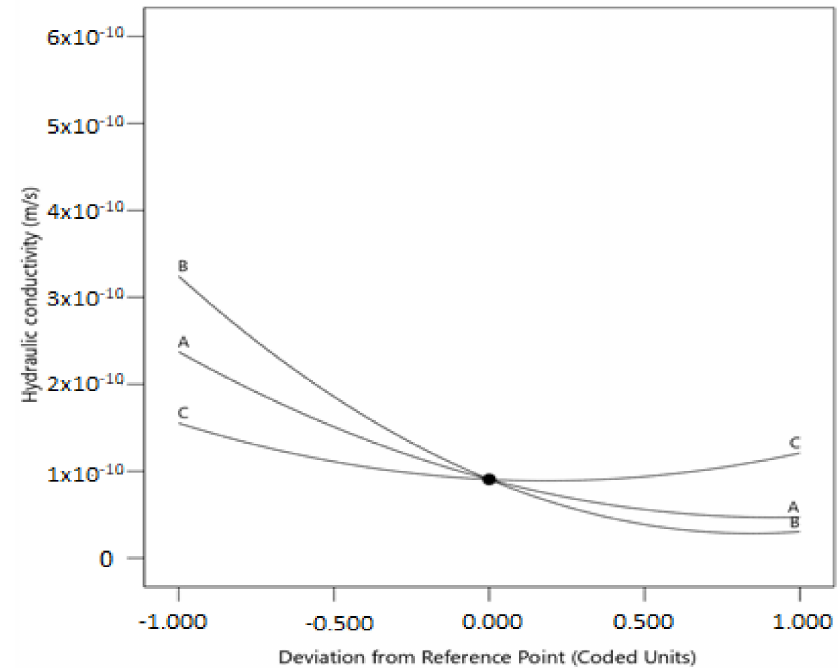
Figure 8. Perturbation